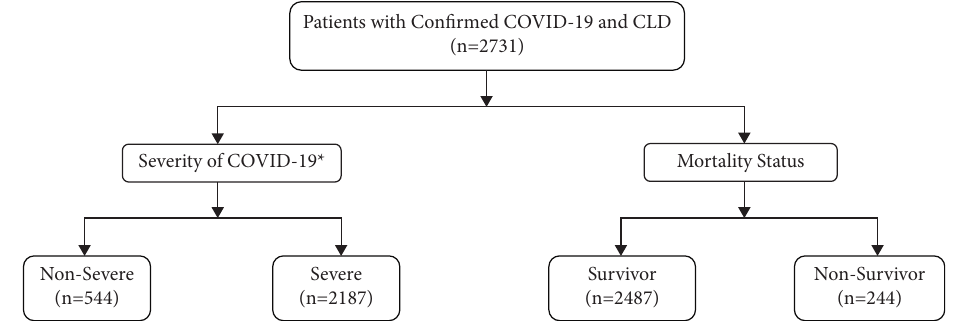
Figure 1: Flow chart of the study. ∗ Severity of the diseases was based on the World Health Organization (WHO) interim guidance. COVID- 19, coronavirus disease 2019; CLD, chronic liver